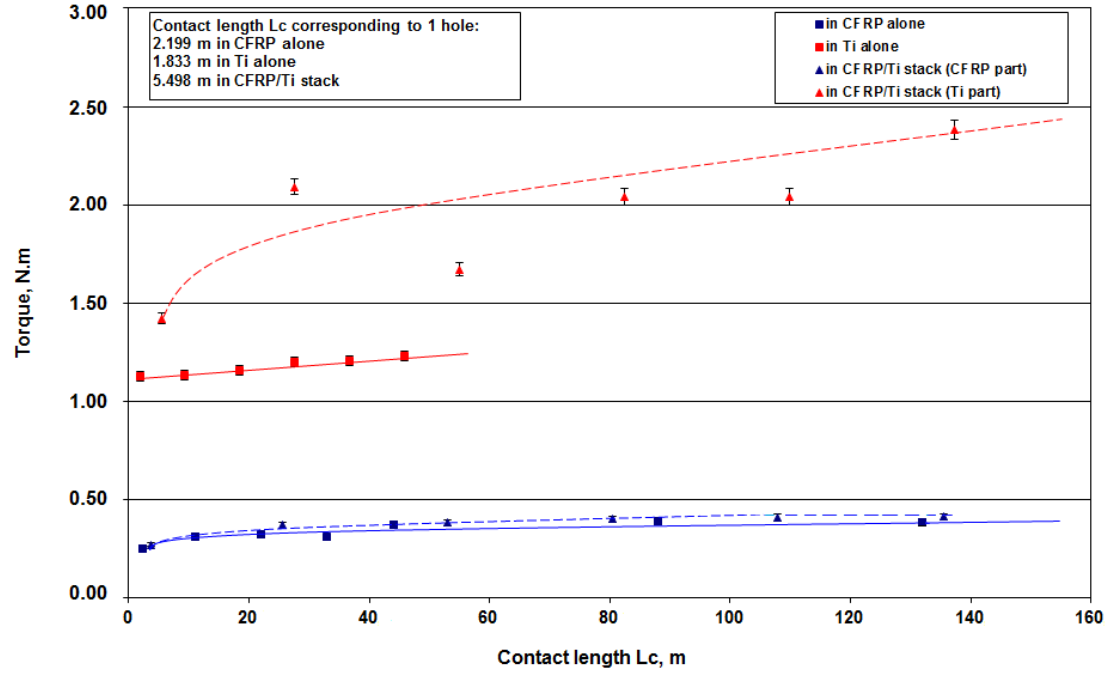
Figure 10. Torque versus contact length Lc in CFRP alone, in Ti-6%Al-4%V alone and in the stack (in the CFRP part and in the Ti-6%Al-4%V part).